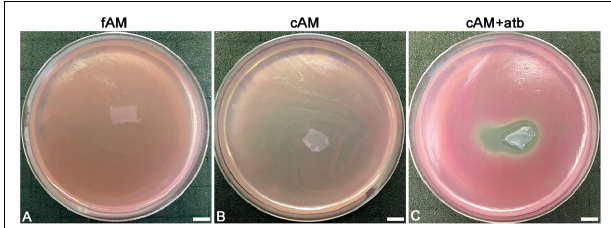
FIGURE 4 | Patches of amniotic membrane could serve as a drug-delivery tool. (A,B) Patches of fresh (fAM) and cryopreserved AM (cAM) have no antimicrobial effect on S. marcescens . (C) When patches of AM are impregnated with an antibiotic (cAM + atb), strong antimicrobial effect on S. marcescens is seen. Three independent replications of experiments using three biological samples were conducted and three technical repeats were performed for each condition. These results were obtained by employing antimicrobial efficiency assay with AM patches embedded in soft agar. Scale bars: 10